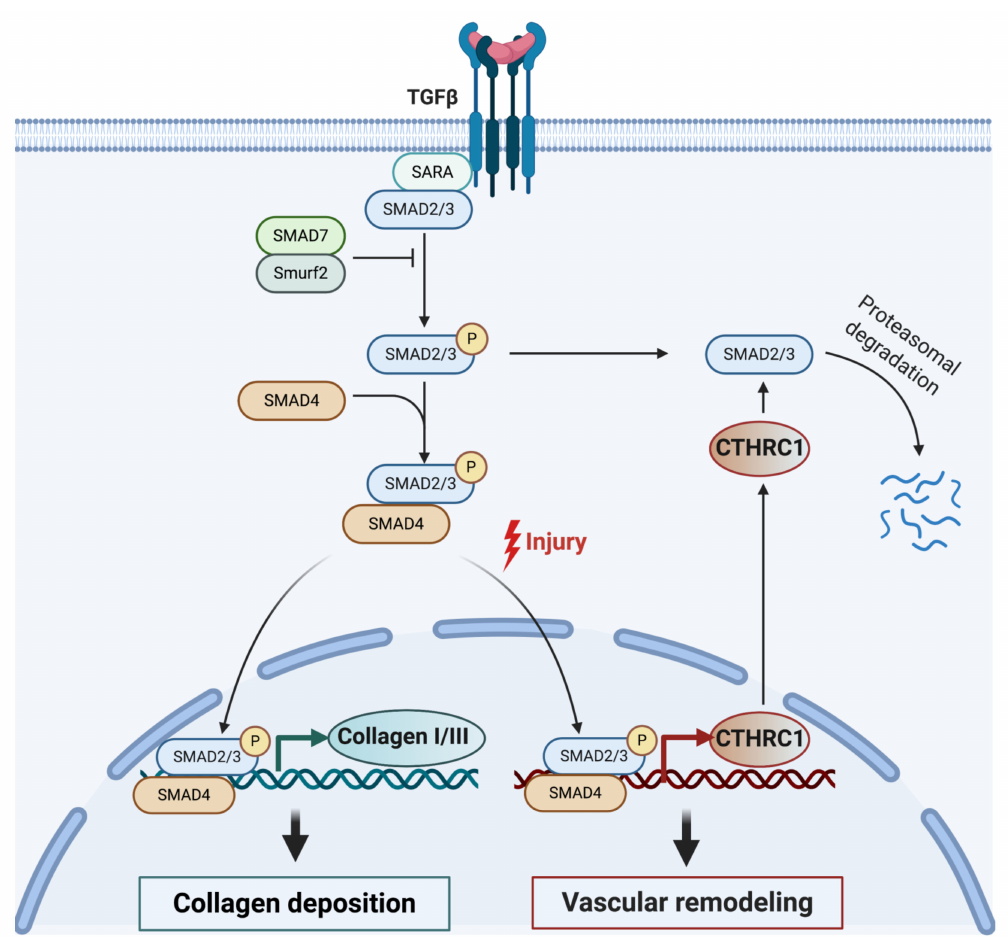
Figure 2. Model for CTHRC1 modulating collagen deposition and vascular repair following injury through the TGF- β signaling pathway. TGF- β is known to stimulate collagen deposition in various cell types by activating receptor-associated SMAD proteins (SMAD2 and SMAD3). Activated SMAD2 and SMAD3 oligomerize with SMAD4. The complex then translocates into the nucleus, where it regulates the expression of TGF- β -responsive genes, including genes encoding collagen I and III, and CTHRC1. Elevated levels of CTHRC1 eventually lead to attenuation of TGF- β signaling by inhibiting SMAD2/3 phosphorylation [36], possibly leading to SMAD2/3 degradation [21]. Created with